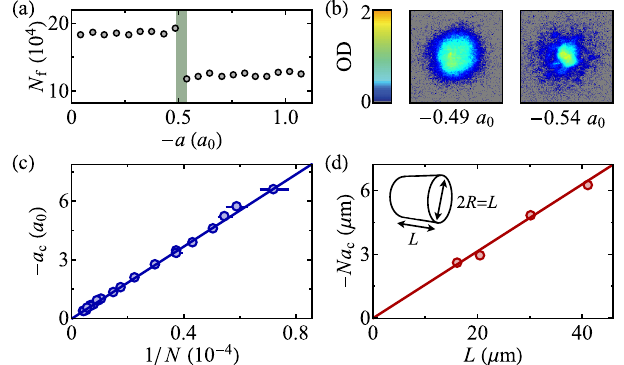
FIG. 2. Critical point for collapse. (a) Final atom number, N , f after ramping to a variable negative a , for L ¼ 30 ð 1 Þ μ m and initial N ¼ 18 . 7 ð 5 Þ × 10 4 . The critical scattering length a is seen c in the sharp drop in N . (b) ToF images taken on either side of the f critical point. (c) Variation of a with N , for L ¼ 30 μ m. The c ∝ 1 =N . (d) Variation of linear fit confirms the expected scaling a c Na ∝ L with L . The linear fit confirms the scaling Na c c